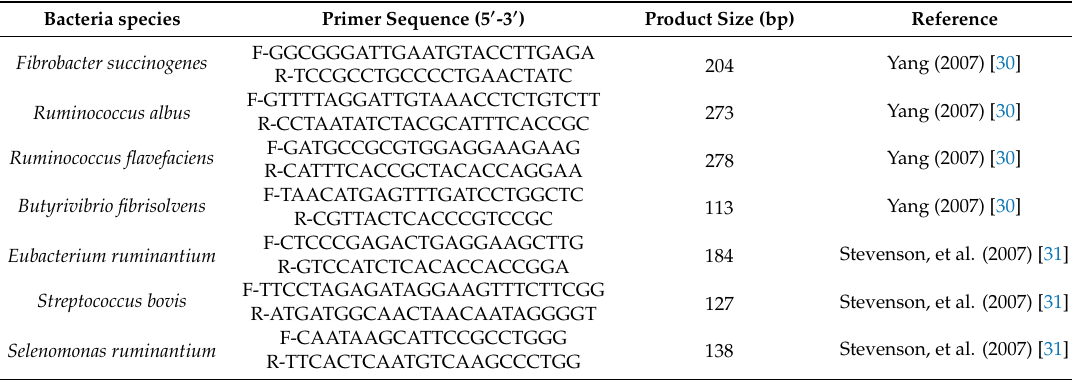
Table 2. Primers for real